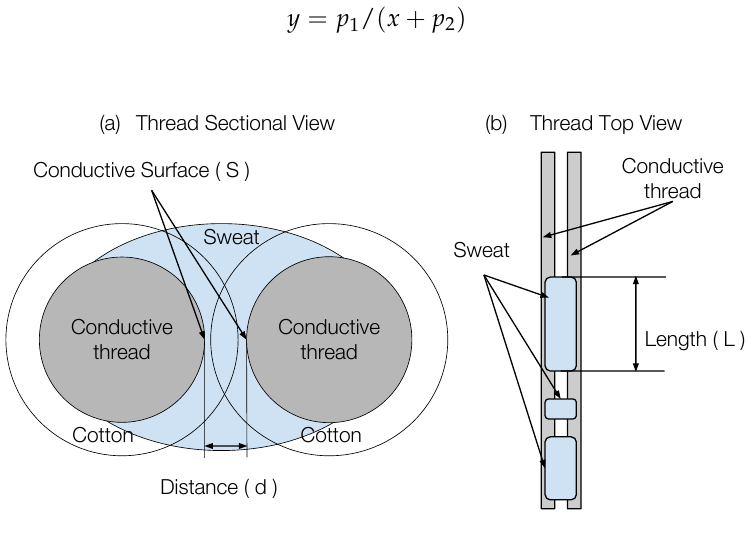
Figure 6. Simplified electrical conductivity model for our sensor